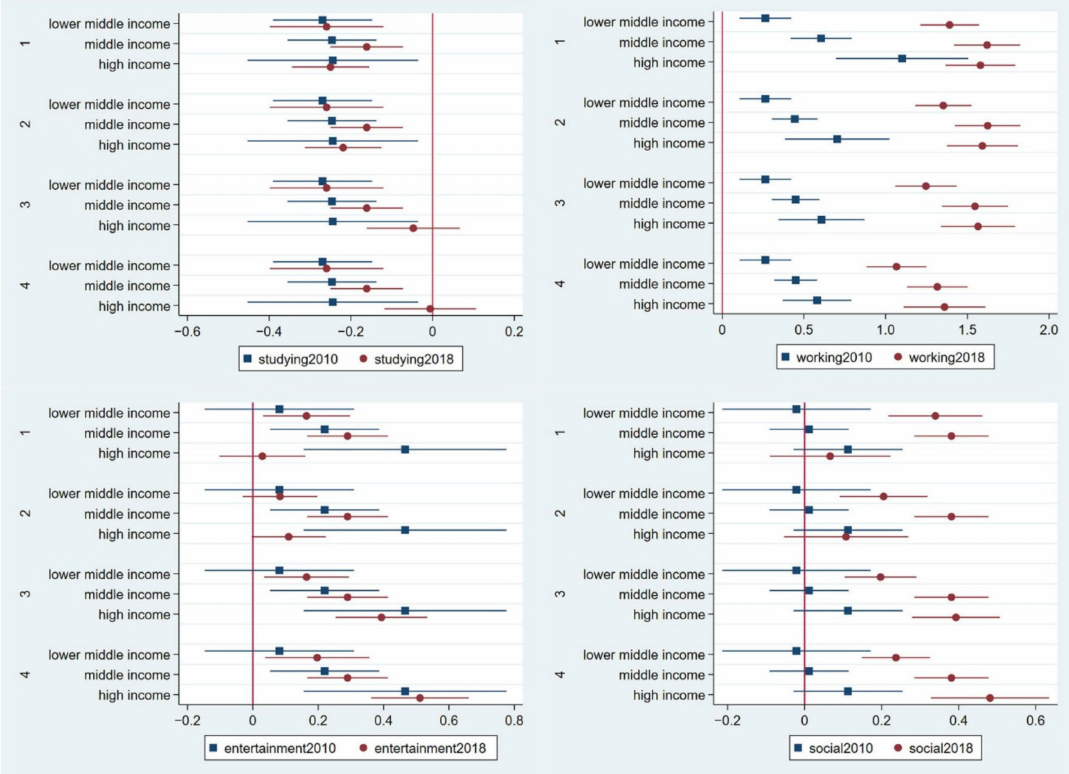
Figure 2. Results of income level from the generalised partial proportional odds model predicting the importance of studying, working, entertainment, and social online activities in the 2010 and 2018 panels. Note: The four panels of internet activity evaluation included the 1st panel (category 1 versus categories 2, 3, 4, and 5); 2nd panel (categories 1 and 2 versus categories 3, 4, and 5); 3rd panel (categories 1, 2, and 3 versus categories 4 and 5); and 4th panel (categories 1, 2, 3, and 4 versus category 5). The detailed data are provided in Supplemental Material Table